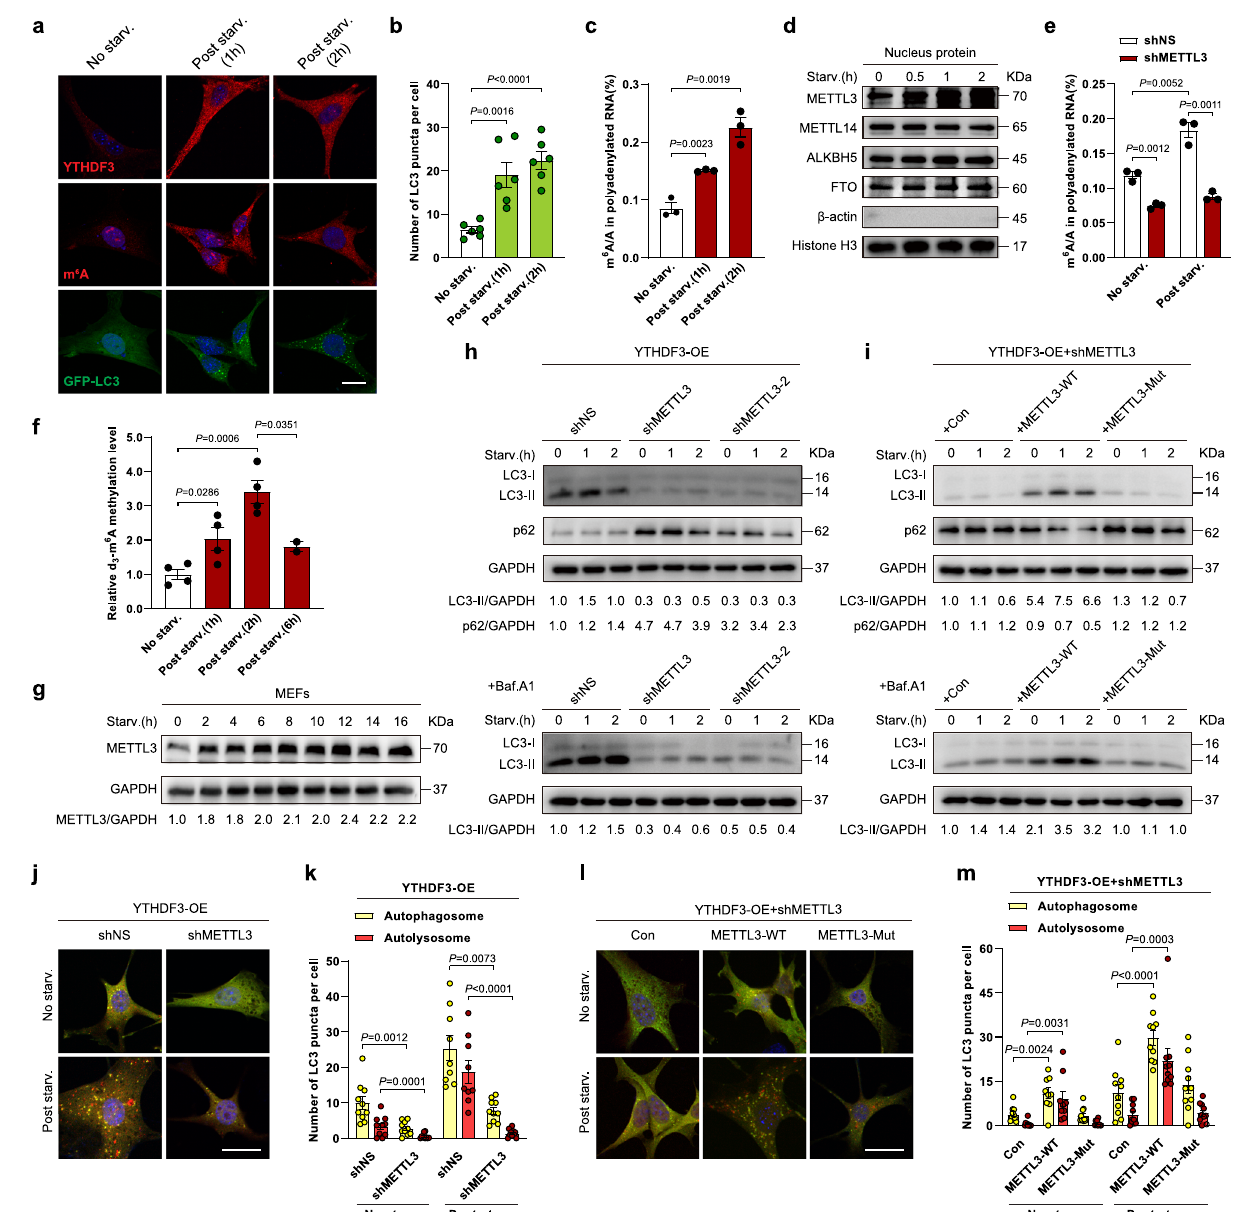
Fig. 3 | YTHDF3 requires METTL3-mediated m 6 A modi fi cation to promote autophagy. a Representative confocal images of YTHDF3 and m 6 A fl uorescence localization were obtained in MEFs following nutrient starvation for the indicated time periods. Nuclei were stained with DAPI. Scale bar, 20 μ m. b Quanti fi cation of GFP-LC3punctapercell. c LC-MS/MSquanti fi cationofm 6 AlevelsinmRNAextracts from MEFs following nutrient starvation for the indicated time periods ( n = 3 bio- logicalreplicates). d ImmunoblotanalysesofnuclearfractionsfromMEFsfollowing nutrient starvation for the indicated time periods. e LC-MS/MS quanti fi cation of m 6 A levels in mRNA extracts from shNS and shMETTL3 MEFs, with or without nutrient deprivation ( n = 3 biological replicates). f The relative m 6 A methylation catalyticactivitiesofpuri fi edMETTL3fromtheMEFsstarvedfortheindicatedtime periods were determined using an RNA probe and d 3 -m 6 A. The methylation yields were calculatedbased on the molar ratioof newly formedd 3 -m 6 A to digestedRNA probes ( n =4, 4, 4, 2 biological replicates). G was used as an internal control to calculate the amount of RNA probes. g Immunoblot analysis of METTL3 in MEFs followingnutrientstarvationfortheindicatedtimeperiods. h Immunoblotanalyses of LC3-II and p62 in YTHDF3-OE MEFs infected with shNS or two independent METTL3shRNAs(shMETTL3andshMETTL3-2)followingnutrientstarvationforthe indicatedtimeperiods,withorwithoutBaf.A1treatment(20nM).GAPDHwasused